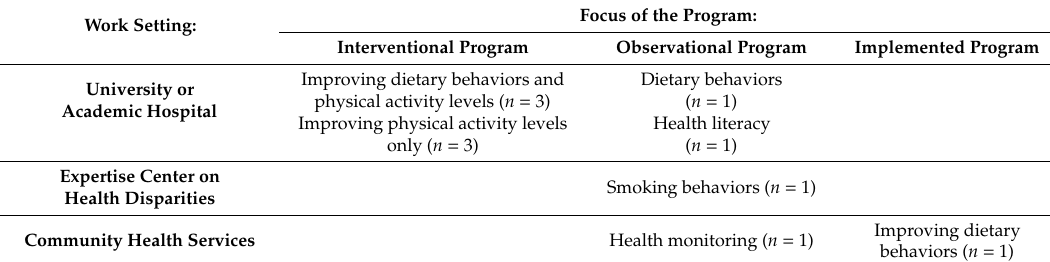
Table 2. Experts’ work setting and focus of a recent or current program ( n = 11).